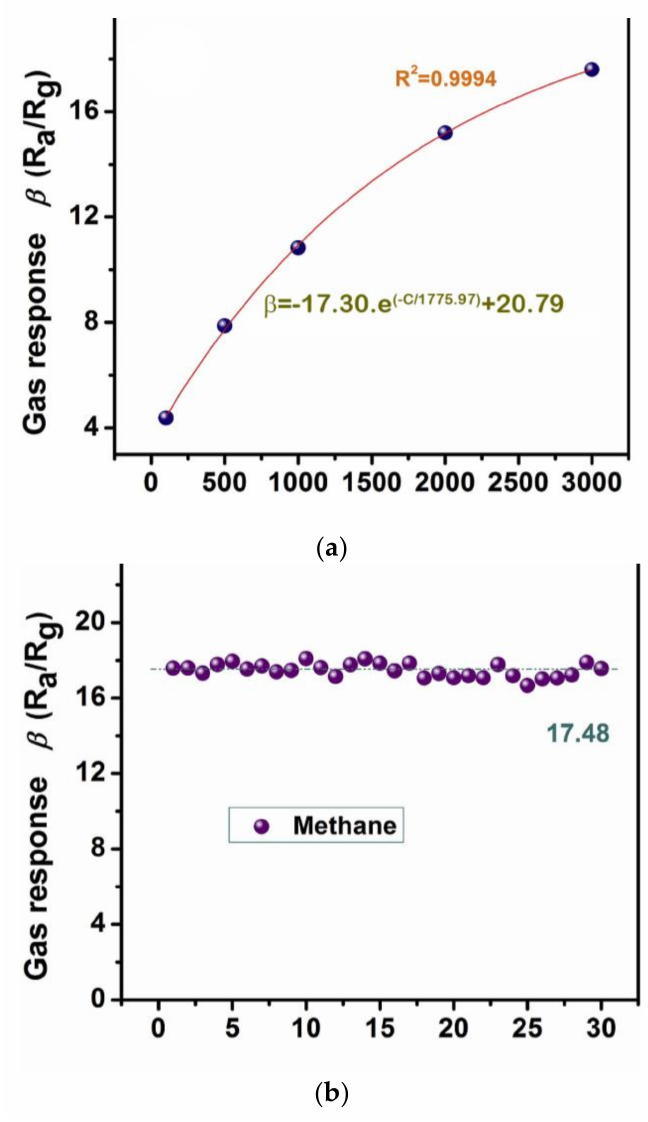
Figure 10. ( a ) The corresponding exponential correlation between the gas response and gas con- centration; ( b ) stability state towards 3000 ppm of methane at 340 ◦ C based on 2.5 mol% Pd-SnO 2 nanoporous composite. Reprinted with permission from reference